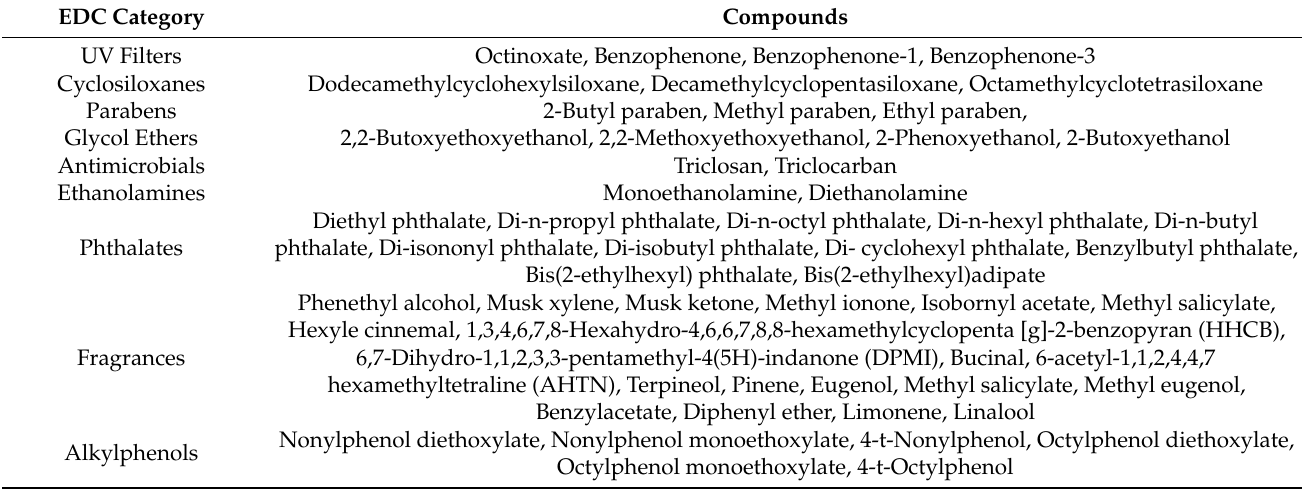
Table 1. Categories of endocrine-disrupting compounds (EDCs) and specific compounds within each category that were included in the EDC footprint